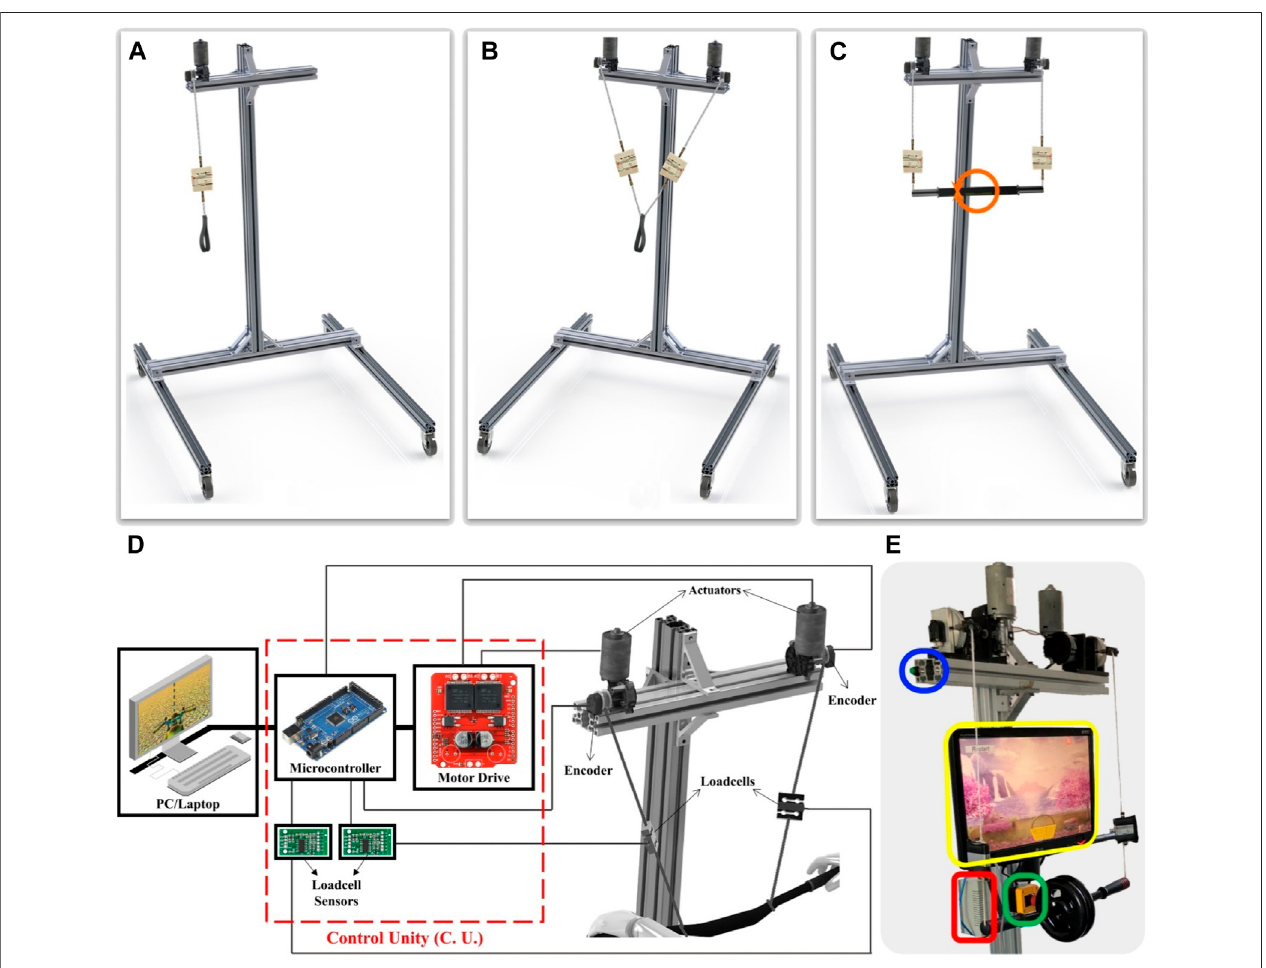
FIGURE1| CAR: (A) 1DOFunilateral, (B) 2DOFunilateraland (C) 2DOFBimanualsetups, (D) connectionsschematic, (E) componentshighlight:controlunit(red), emergency (green) and action (blue) buttons, feedback unit (yellow).